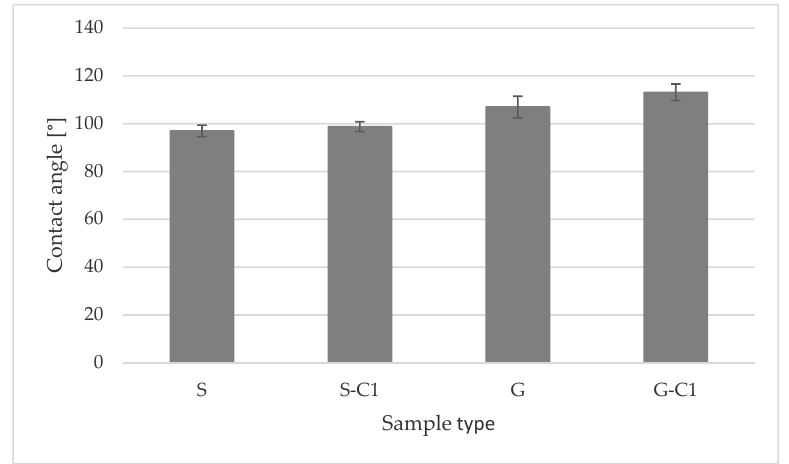
Figure 10. Mean contact angle values for smooth and geometrised samples, non-modified and subjected to chemical modification (S—smooth, non-modified sample, S-C1—smooth, chemically modified sample, G—geometrised, non-modified sample, G—C1 geometrised, chemically modified sample). Table 5. Results of contact angle measurements after laser texturing for chemically non-modified samples and samples after C1 modification.